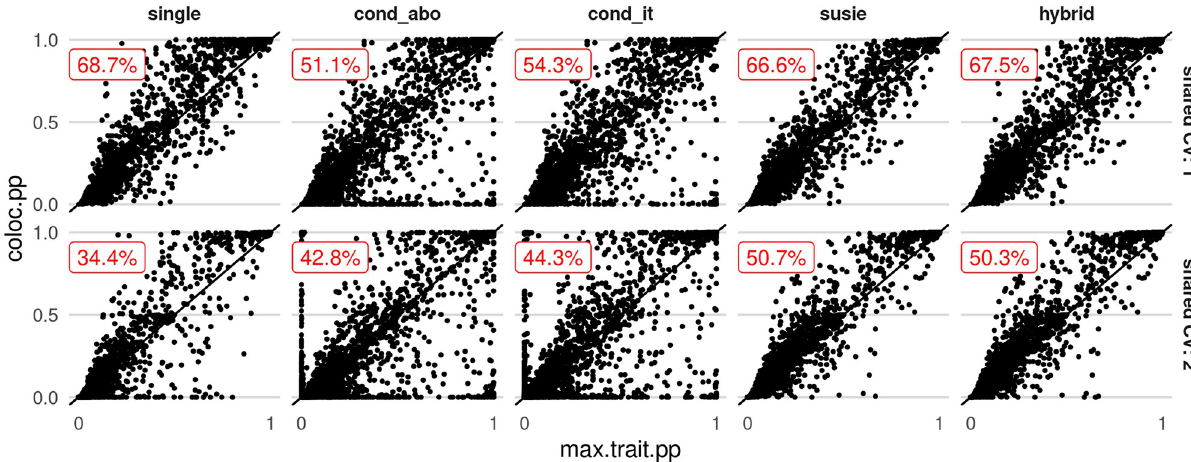
Fig 4. Fine mapping posterior probabilities at causal variants in single trait and coloc analysis, amongst datasets with high probability of colocalisation ( P ( H 4 |Data) > 0.9) according to the method shown. Each point represents one causal variant in a dataset; its x location shows its maximum fine mapping posterior probability (PP) in either single trait, its y location shows its PP after coloc. Results are divided by rows into those from datasets with 1 (top) or 2 (bottom) causal variants, and by columns according to method. The text in red shows the percent of datasets which led to an increase in PP at causal variants after coloc